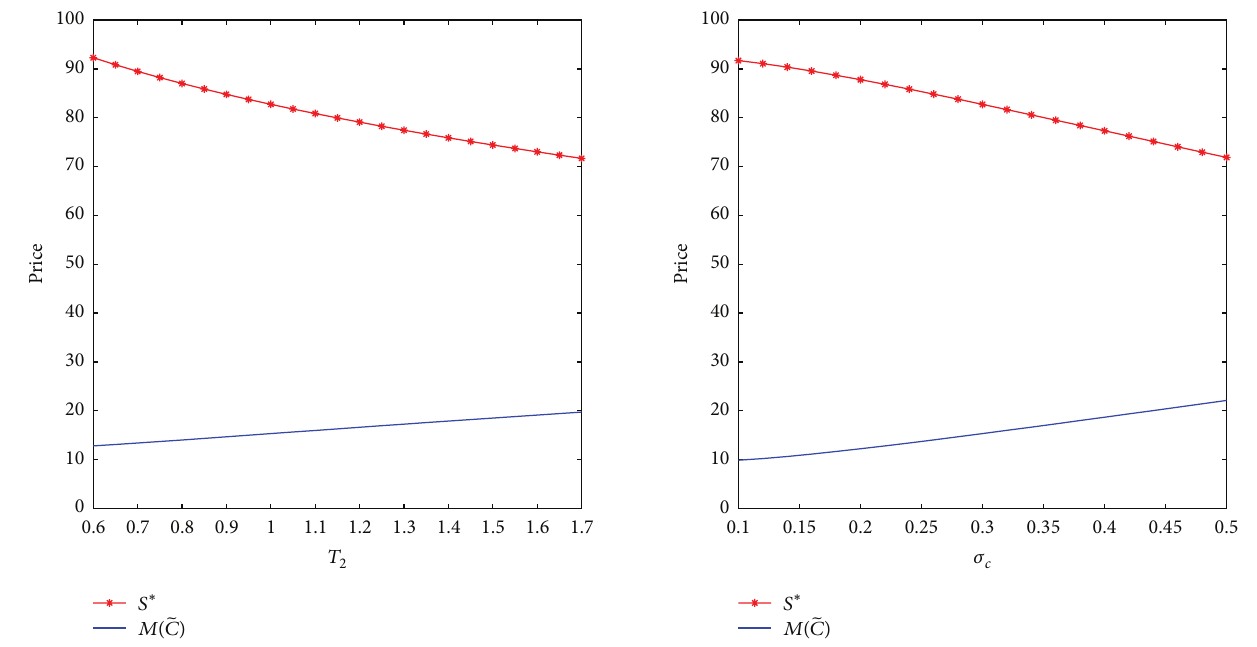
Figure 5: The sensitivity analysis of 𝑆 ∗ and